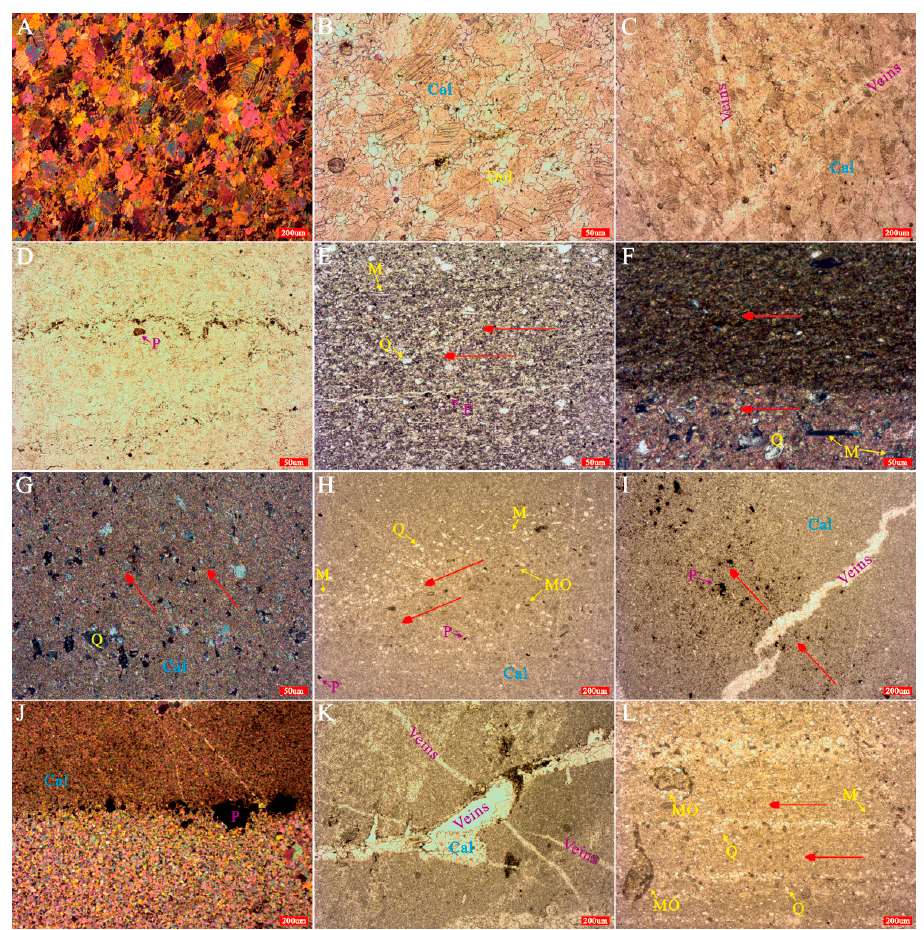
Figure 2. Photomicrograph of the Nafun Group. ( A ) Sparry limestone, medium-coarsely crystalline, sutured contact, Khufai Formation, orthogonal polarization; ( B ) Dolomitic limestone, medium crystalline mosaic calcite and finely crystalline dolomite, concave-convex contact, Khufai Formation, polarization; ( C ) Sparry limestone, medium-coarsely crystalline, abundant veins, residual organic matter, Khufai Formation, polarization; ( D ) Sparry limestone, wavy organic matter, maroon pyrite, Khufai Formation, polarization; ( E ) Siltstone, interbedded with same orientation minerals, narrow tabular muscovite, calcareous cementation, Shuram Formation, polarization; ( F ) Shale overlying sandy limestone, abundant organic matter in the shale, abundant quartz and narrow tabular muscovite crystals in the limestone, all minerals in the same orientation, Shuram Formation, orthogonal polarization; ( G ) Sandy limestone, very finely crystalline calcite matrix, interbedded with same orientation quartz crystals, Shuram Formation, orthogonal polarization; (H) Limestone, very finely crystalline calcite matrix, laminated quartz and muscovite crystals, pyrites and microorganisms, Shuram Formation, polarization; ( I ) Limestone, micrite calcite matrix, calcite veins, laminated pyrites, Shuram Formation, polarization; ( J ) Limestone, micrite calcite overlies finely crystalline calcite, laminated pyrites, Buah Formation, orthogonal polarization; ( K ) Limestone, finely crystalline calcite matrix, calcite veins, remaining bitumens in the veins, Buah Formation, polarization; ( L ) Limestone, finely crystalline calcite, laminated abundant quartz and muscovite crystals; microorganisms, sizes range mostly from 10 to 50 µm, occasionally from 200 to 800 µm; Buah Formation, polarization. Mineral abbreviations: Cal: Calcite; Dol: Dolomite; Q: Quartz; M: Muscovite; P: Pyrite; MO: Microorganism.